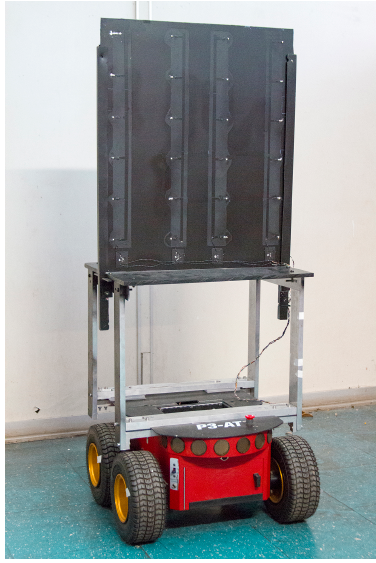
Figure 2. Pioneer 3 AT used in the experiments in the intelligent space at UFES.